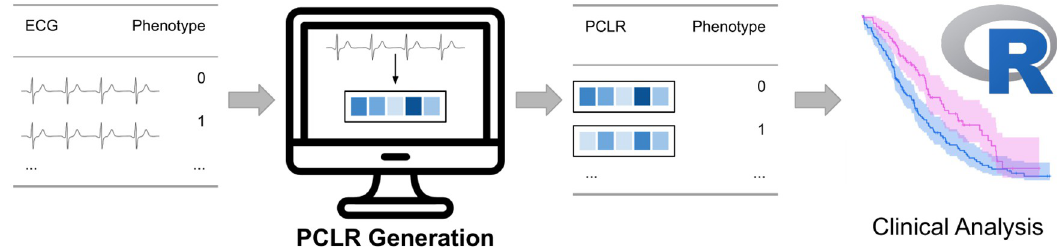
Fig 1. Example workflow using PCLR. A clinical researcher uploads ECGs to a service which returns a PCLR representation for each ECG. The representations can then be used by the clinician in models standard to clinical research workflows, including, for example, Cox proportional hazards